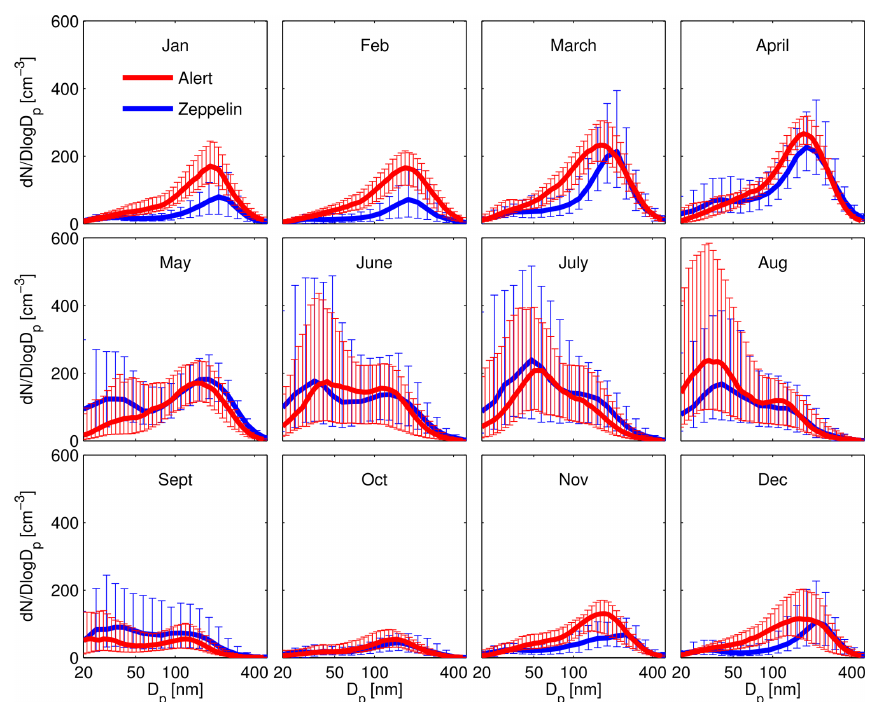
Figure 6. Aerosol size distributions from Alert and Zeppelin Arctic field stations. The pronounced accumulation mode in the winter and spring is characteristic of Arctic haze. The mode of Aitken particles is a common feature of the Arctic summertime atmosphere. Figure from Croft et al.